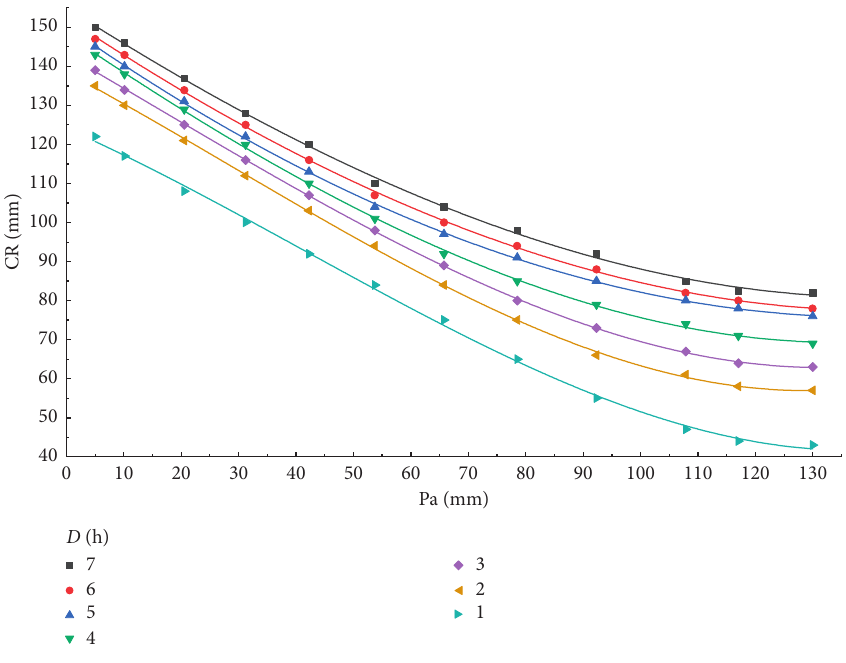
Figure 8: CR-Pa curves of different durations.